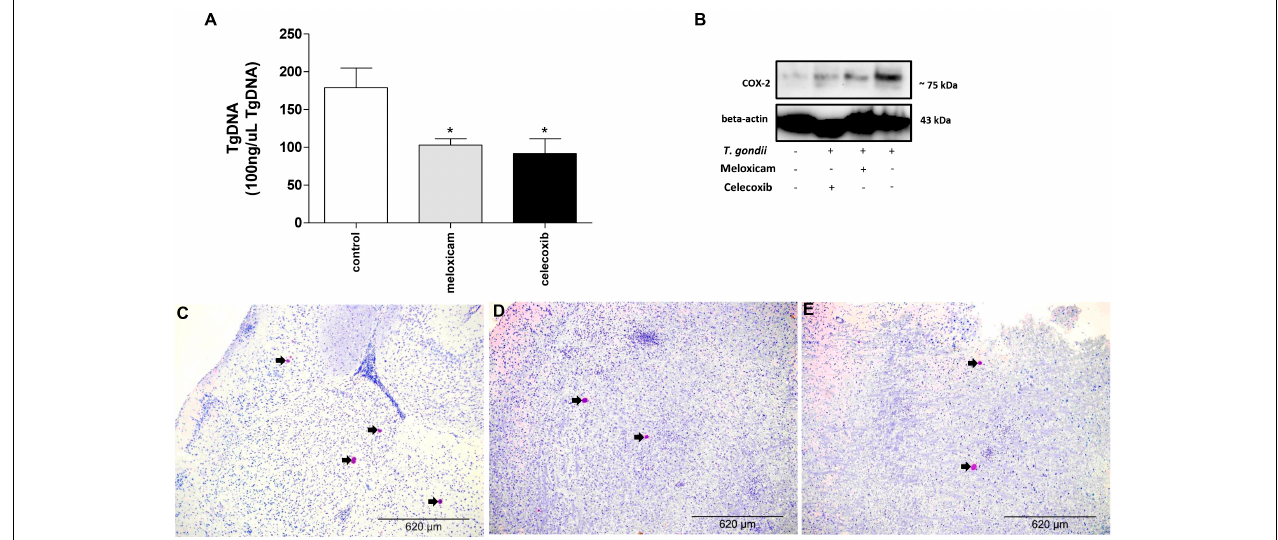
FIGURE 2 | Parasite burden and COX-2 expression in C. callosus after infection with T. gondii and treatment with COX-2 inhibitors. Females were infected orally with 50 cysts of T. gondii (ME49 strain), treated or untreated with meloxicam (0.5 mg/kg) or celecoxib (5 mg/kg) daily, euthanized after 40 days of infection and treatment, and the brains collected and analyzed by real-time PCR to quantify the parasite burden (A) or Western blotting to detect COX-2 and beta-actin expressions (B) . The data are shown as T. gondii DNA (TgDNA) concentration in 100 ng/ µ L total DNA (A) . Differences between groups were analyzed by one-way ANOVA with the Bonferroni multiple comparison post hoc test. Significant differences in relation to untreated/infected animals (control) ( ∗ P < 0.05) (A) . Representative photomicrographs of brains of C. callosus infected and untreated (control) (C) , infected and treated with meloxicam (D) or celecoxib (E) . Immunohistochemical sections counterstained by Harris’s hematoxylin. Arrows indicate parasites inside the cyst-like structures. Bar scale: 620 µ